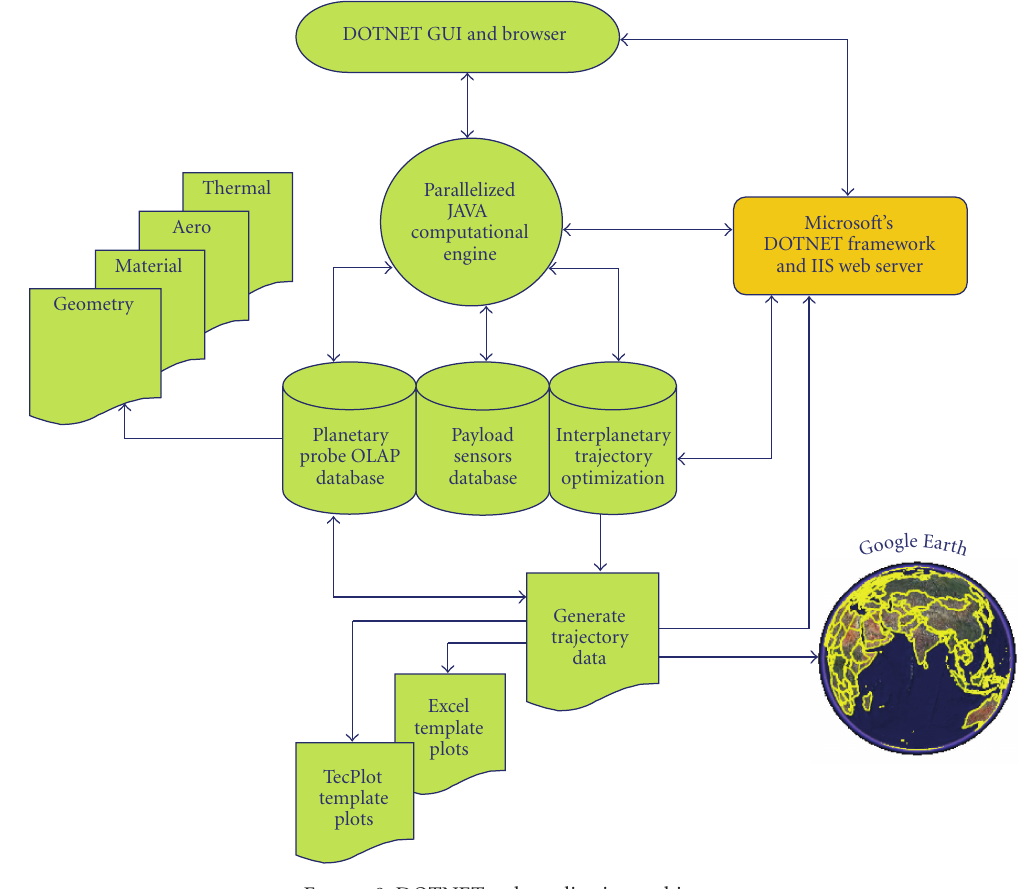
Figure 8: DOTNET web application architecture.